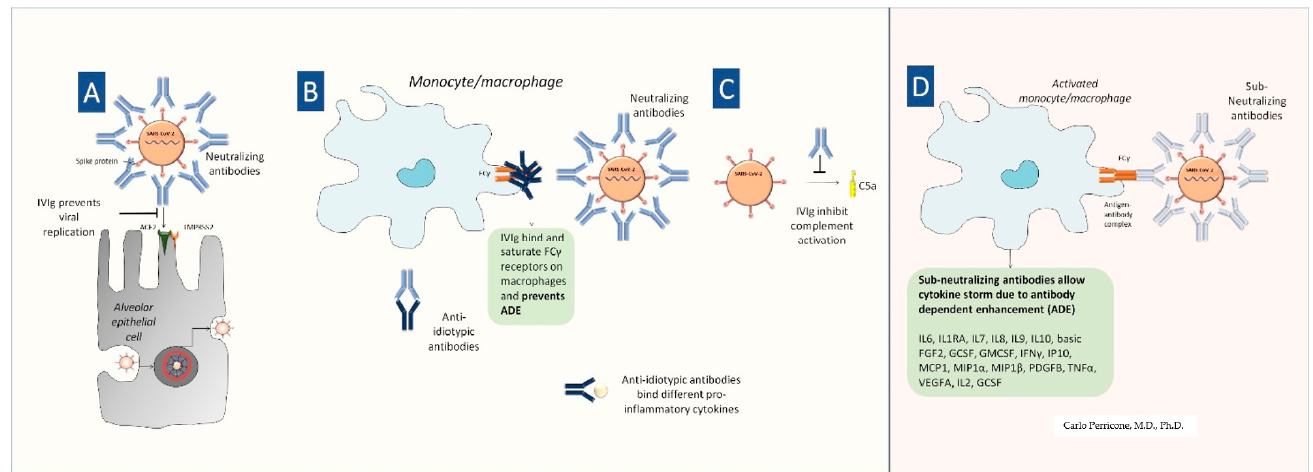
Figure 1. The hypothetical dual role of IVIG in SARS-CoV-2 infection. IVIG can be beneficial since ( A ) neutralizing antibodies binding spike protein may prevent SARS-CoV-2 attachment to the ACE2 receptor thus inhibiting viral entry into the cell and in turn viral replication; ( B ) IVIG can bind and saturate Fc γ receptors on innate immune cells (e.g., macrophages) in the lungs, thus preventing ADE. Anti-idiotypic antibodies can bind to anti-viral antibodies as well as to proinflammatory cytokines. ( C ) IVIG are well-known modulators of the complement cascade activated by SARS-CoV-2; ( D ) Fc receptor-mediated ADE may occur when antiviral neutralizing antibodies cannot completely neutralize the virus thus macrophages (and other innate immune cells) are stimulated towards the exaggerated inflammatory response leading to the cytokine storm. [ A, B, C, and D in the figure refer to the same letters in the above-mentioned comments in the text.].